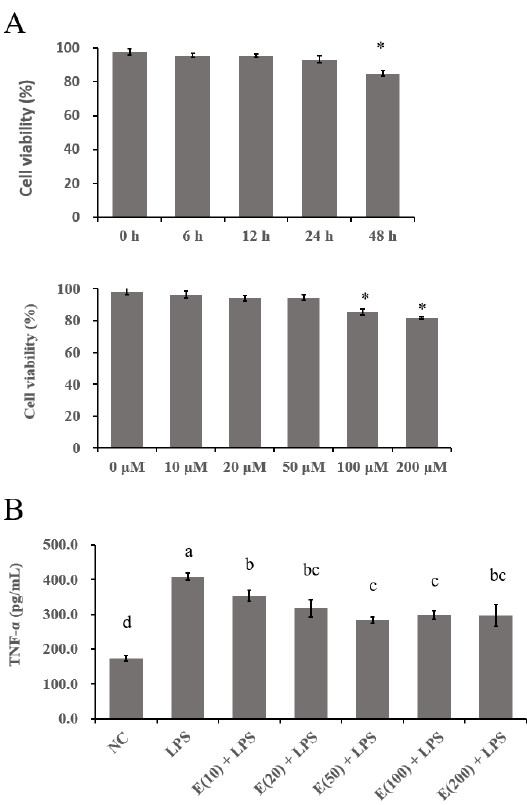
Figure 1. Cell viability and TNF- α secretion of cells treated with different concentrations of EGCG followed by LPS-challenge. Cells were treated with EGCG at concentrations of 0, 10, 20, 50, 100, and 200 µ M for 24 h. Meanwhile, the EGCG treatments of hepatocytes were conducted for 0, 6, 12, 24, 48 h at a concentration of 50 µ M. Absorbance for cell viability or TNF- α was measured at 450 nm. The results are expressed as means ± S.E.M. * p < 0.05 vs. the control group ( A ), and the letters in superscript indicate that the difference between groups was significant ( p < 0.05) ( B ). Data are representative of three independent